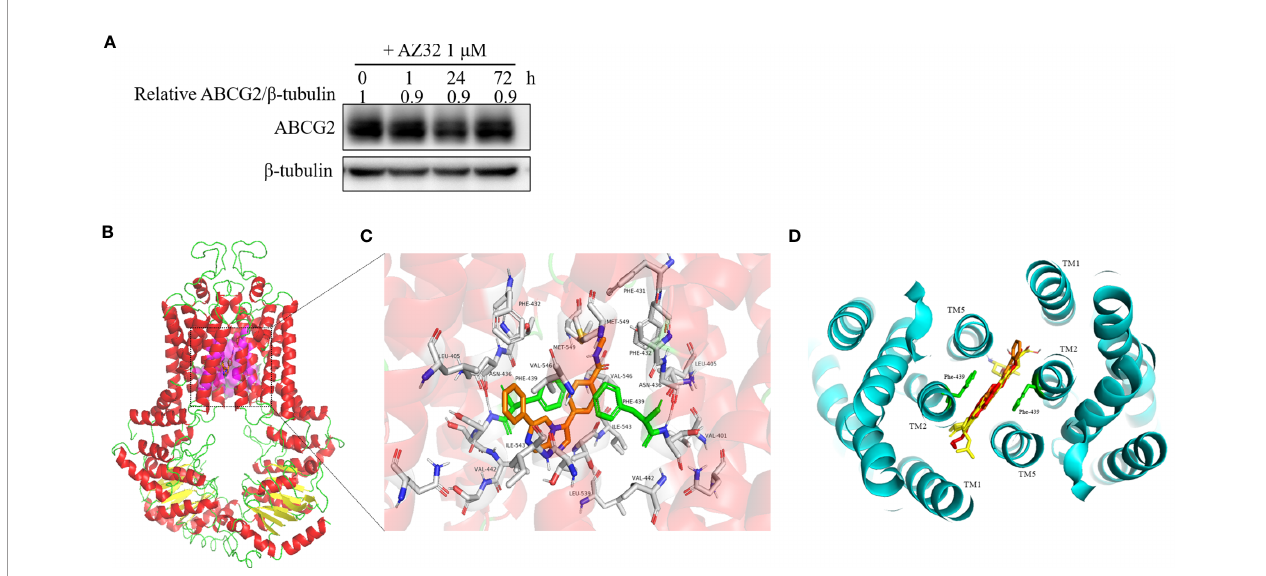
FIGURE 4 | AZ32 does not alter the protein expression of ABCG2 in colorectal cancer cells and model for binding of AZ32 to ABCG2. S1-M1-80 cells were treated with AZ32 at 1 m M for the indicated time points. The protein expression levels of ABCG2 were examined by Western blot, and b -tubulin was used as loading control (A) . The optimal docked pose of AZ32 within the putative multidrug-binding site of human ABCG2 based on the crystal structure available from PDB. ABCG2 conformation is presented as a ribbon diagram and colored by secondary structure: read-helix, yellow-sheet, green-loop. AZ32 is shown as stick mode within a slit- like cavity of ABCG2, and the binding surface is exhibited as magenta (B) . Zoomed-in the highlighted area shows that AZ32 is sandwiched between Phe-439 (colored green) side chains, and AZ32 interacts favorably with the hydrophobic residues Val-401, Leu-405, Phe-431, Phe-432, Leu-439, Val-442, and Ile-543 (shown as sticks, labeled) (C) . The binding site of AZ32 (orange sticks) overlaps with FTC, mitoxantrone and doxorubicin (displayed as yellow, green and red sticks respectively), viewed from the extracellular space of the structure of ABCG2 (D)